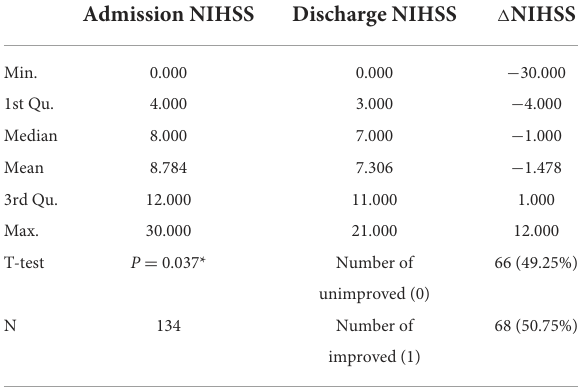
TABLE 2B Comparison of NIHSS before and after admission.